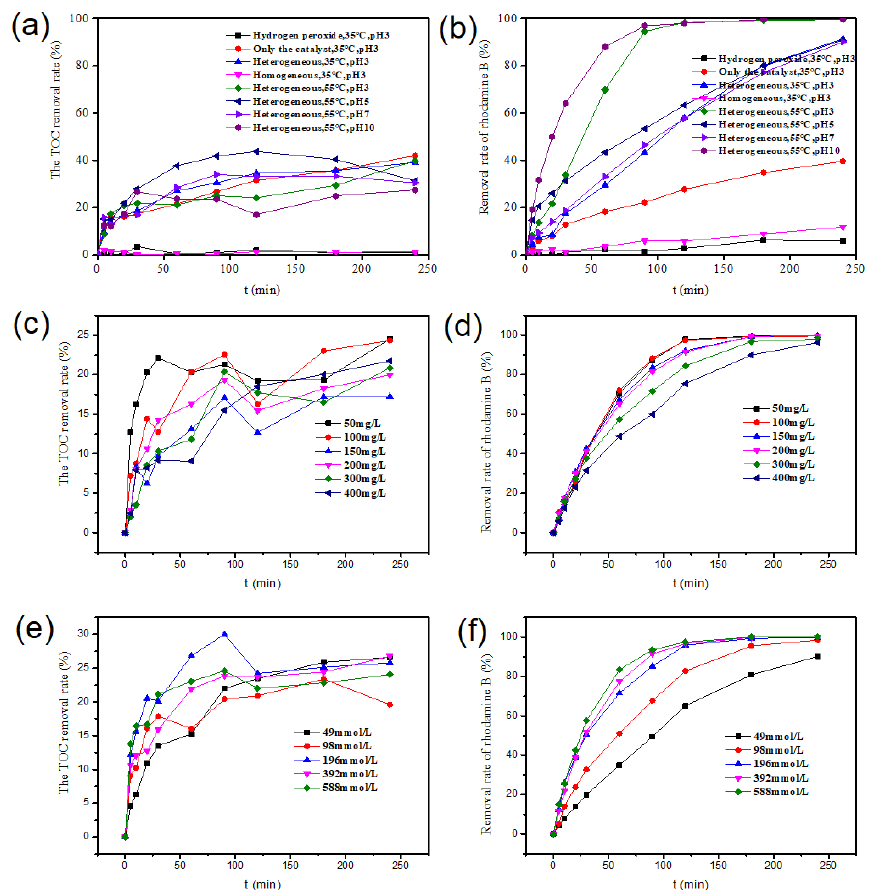
Figure 3. Effects of different reaction systems ( a , b ) ( 𝑐 0 = 100 mg/L, 𝑐 𝐻 = 196 mmol/L, catalyst = 10 g/L); ( c , d ) RhB initial concentration ( 𝑐 𝐻 = 196 mmol/L, catalyst = 10 g/L, pH = 10, T = 55 °C); ( e , f ) H 2 O 2 concentration ( 𝑐 0 = 200 mg/L, catalyst = 10 g/L, pH = 10, T = 55 °C); on degradation and mineralization rate of Rhodamine B.